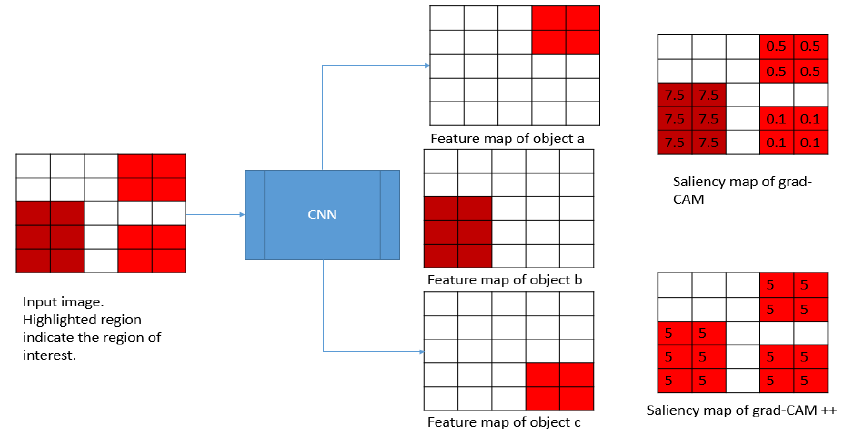
Figure 2. The intuition behind Grad-CAM.